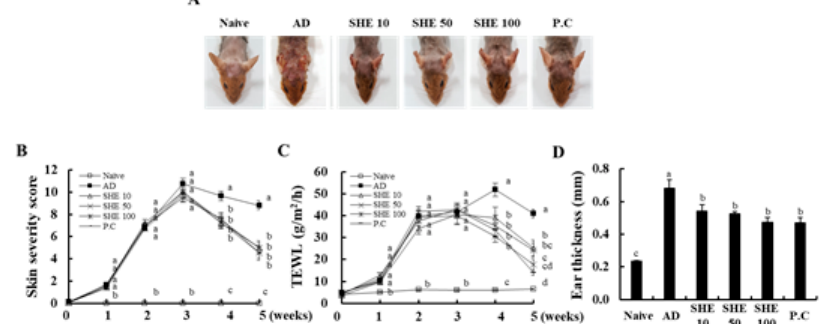
Figure 2. Suppression of HDM/DNCB-induced AD by oral administration of SHE (10, 50, and 100 mg/kg). ( A ) Comparing photographs of HDM/DNCB-induced skin lesions in NC/Nga mice after repeated oral administration of SHE. ( B ) Comparison of clinical skin severity scores of skin symptoms for 5 weeks after sensitization. ( C ) Comparison of TEWL value for 5 weeks after sensitization. ( D ) Comparison of ear thickness on day 35. Values were the mean ± SD of triplicate experiments. a–d Values with different alphabets were significantly different at p < 0.05 ( n = 8 ).